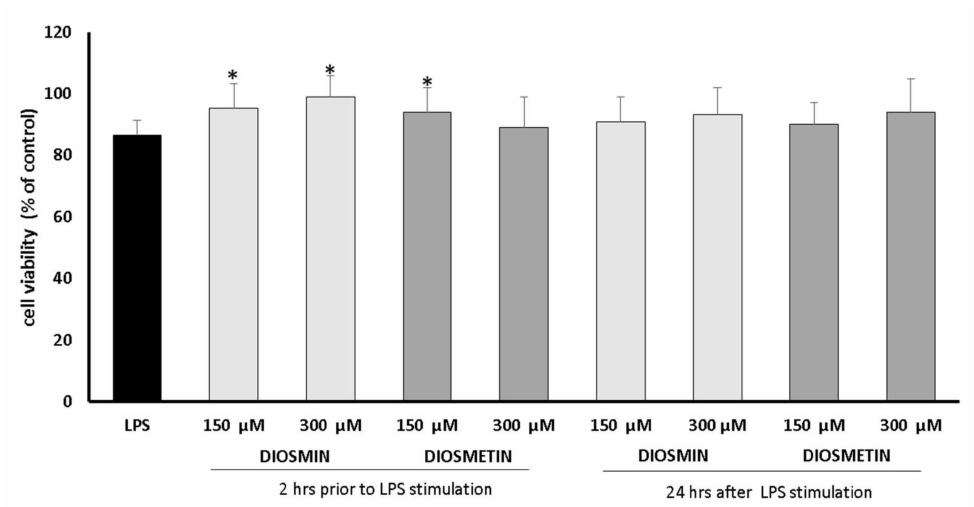
Figure 1. Cell viability determined by the MTT assay and expressed as a % of control (0.5% DMSO). Cells were treated with diosmin and diosmetin 2 h prior to or 24 h after LPS stimulation. The data are means ± SD ( n = 3). One-way ANOVA followed by Dunnett’s multiple comparison post hoc test; the differences were considered significant at p ≤ 0.05. * indicates statistically significant